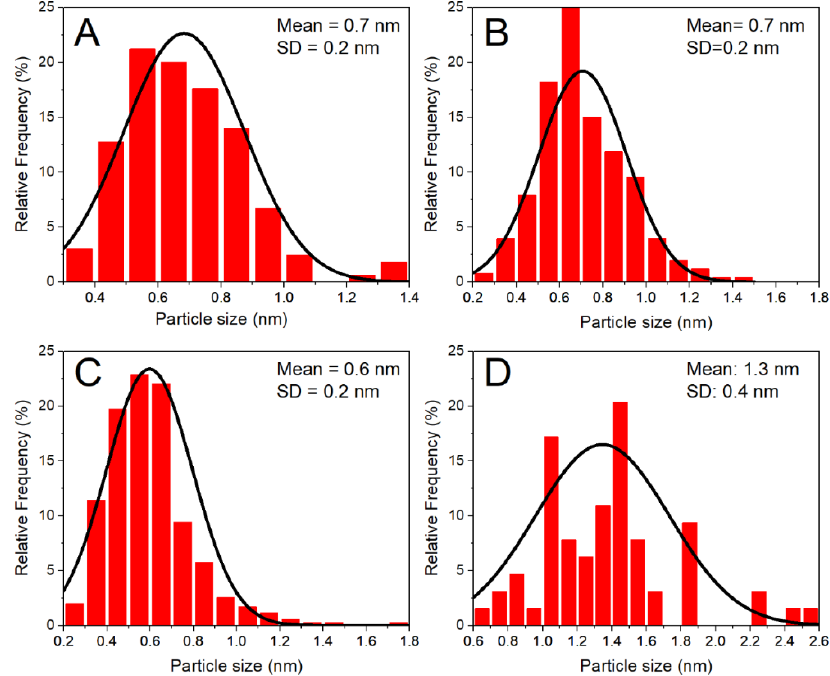
Figure 3. Ru particle size distribution histograms from TEM images of Ru-14 ( A ), Ru-28 ( B ), Ru-41 ( C ) and Ru-70 ( D ).